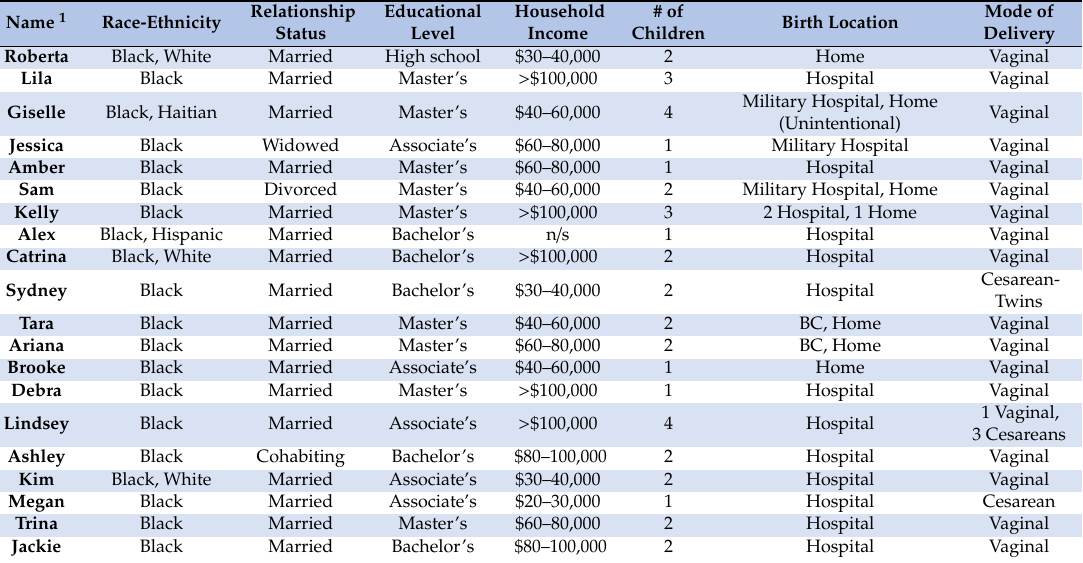
Table 1. Demographic Characteristics and Related Attributes of